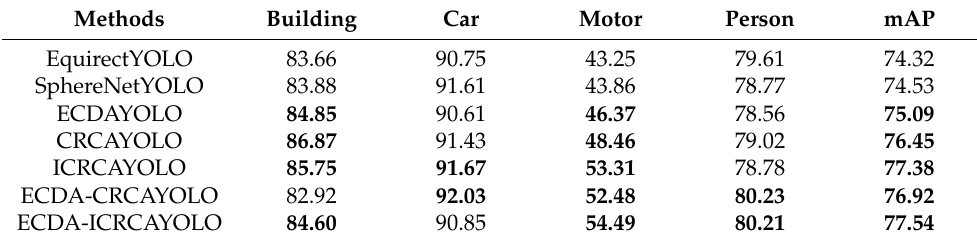
Table 3. Test results for the different models on ERP-Detect.